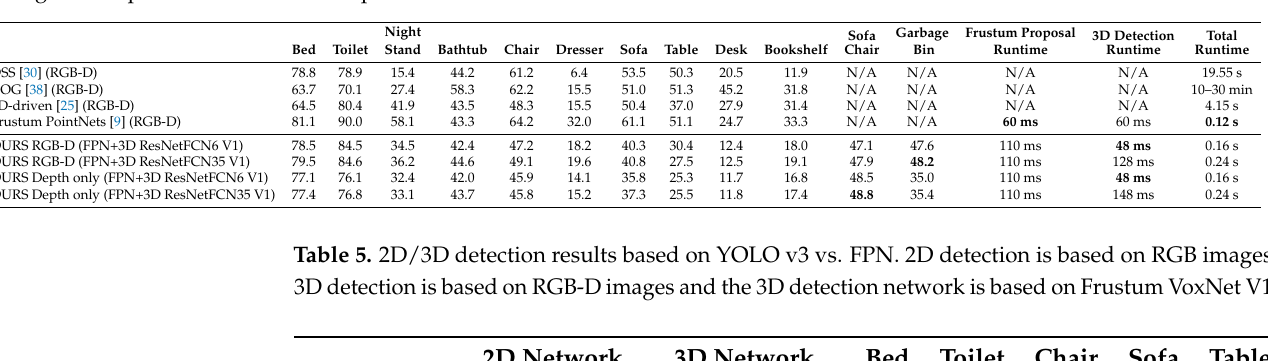
Table 4. 3D detection results of system V1 on SUN RGB-D validation set. Evaluation metric is average precision with IoU threshold of 0.25 as proposed by [7]. Both Clouds of Oriented Gradients (COG) [38] and 2D-driven [25] are using room layout context to boost performance while ours, Deep Sliding Shapes (DSS) [30], and Frustum PointNets [9] are not. Frustum PointNets [9] is using the 3D segmentation information to train the network to boost the 3D detection, while our system V1 and DSS [30] are not. Our system V2 uses the 3D segmentation information, and the results of V2 have a significant performance boost compared with V1.